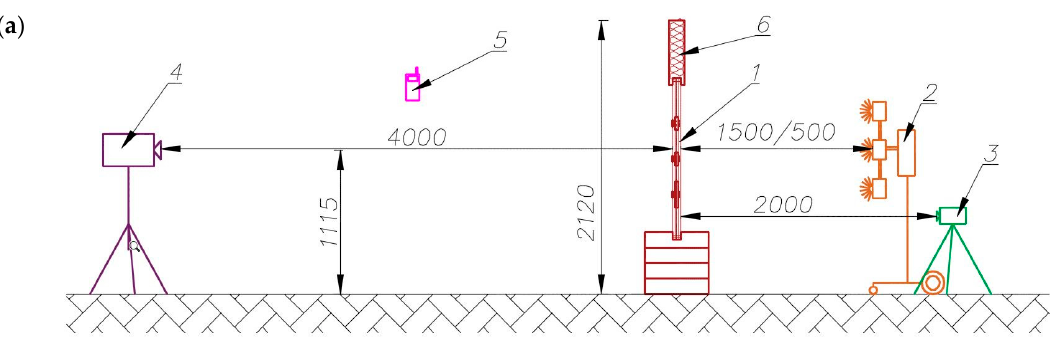
Figure 1. Geometrical structure of the partition model (given units in mm): ( a ) arrangement of material inclusions, internal structure. ( b ) View of the 3D partition model where inner boards with holes and inclusions are marked blue and red, while the outer boards are marked violet and grey. Designations in figures: 1 – XPS inclusion, 2 – granite inclusion, 3 – steel inclusion, and R – homogenous area without inclusion.